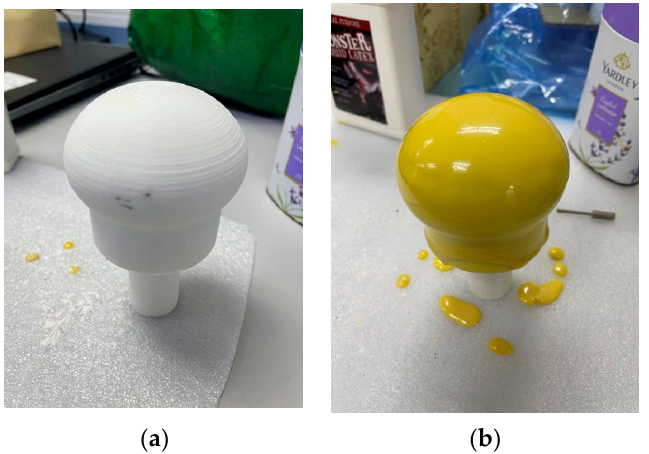
Figure 7. Dip molding of membrane: ( a ) 3D-printed mold; ( b ) molded membrane after dipping the mold in latex.